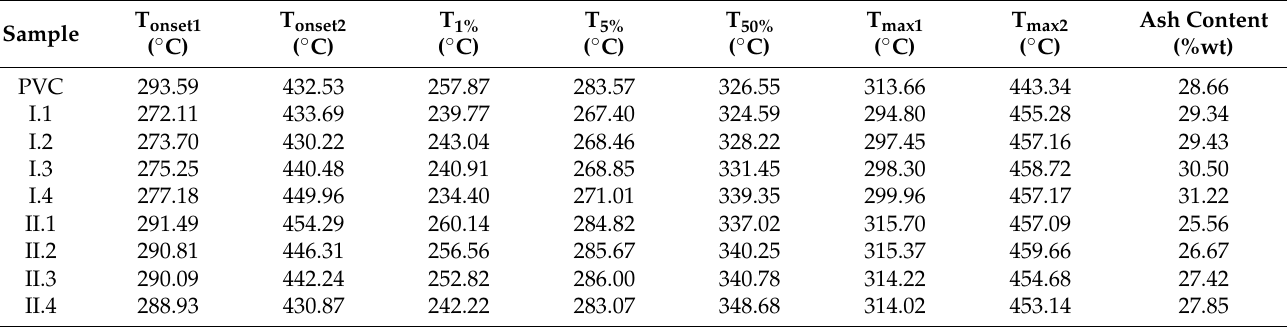
Figure 12 . DTG of PVC and PVC composites. Table 9 . Thermal characteristics of PVC and PVC composites.